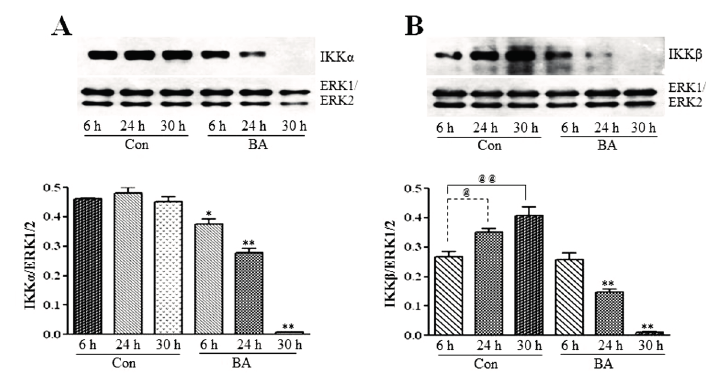
Figure 7. Butyrate downregulates IKK α and IKK β . VSMC were untreated (Con) or treated with 5 mM butyrate (BA) for the indicated periods of time. At the end of the treatment period, cell lysates were prepared and processed for western analysis. Band intensities are normalized to ERK1/ERK2 and presented as a bar graph in the bottom panels. Values are presented as the mean ± SD of three independent experiments. ( A ) IKK α expression is detected by using anti-IKK α antibody. * p < 0.01 and ** p < 0.001 against respective controls (Con). ( B ) IKK β protein expression is evaluated by using anti-IKK β antibody.